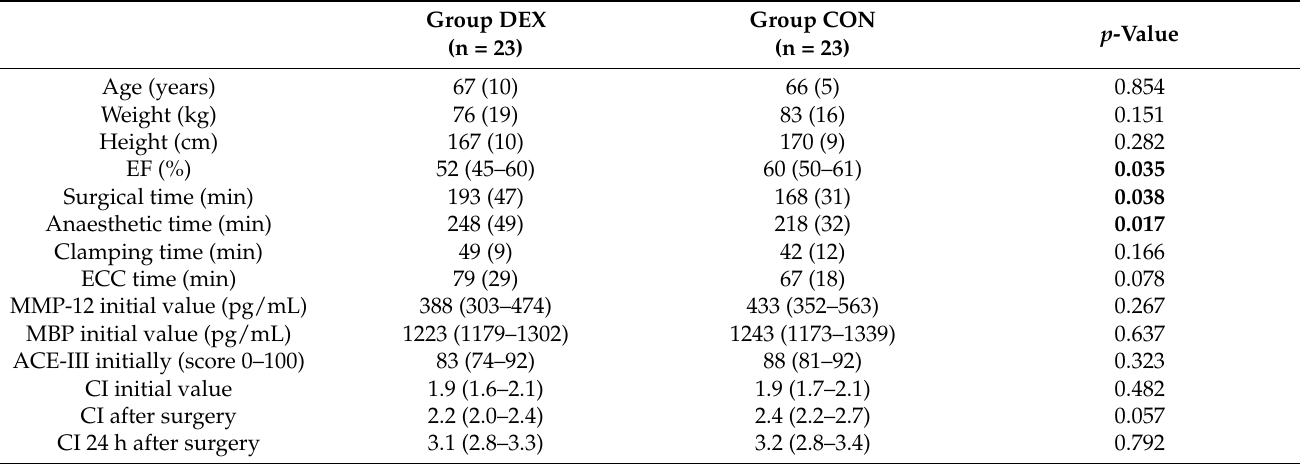
Table 1. Patient